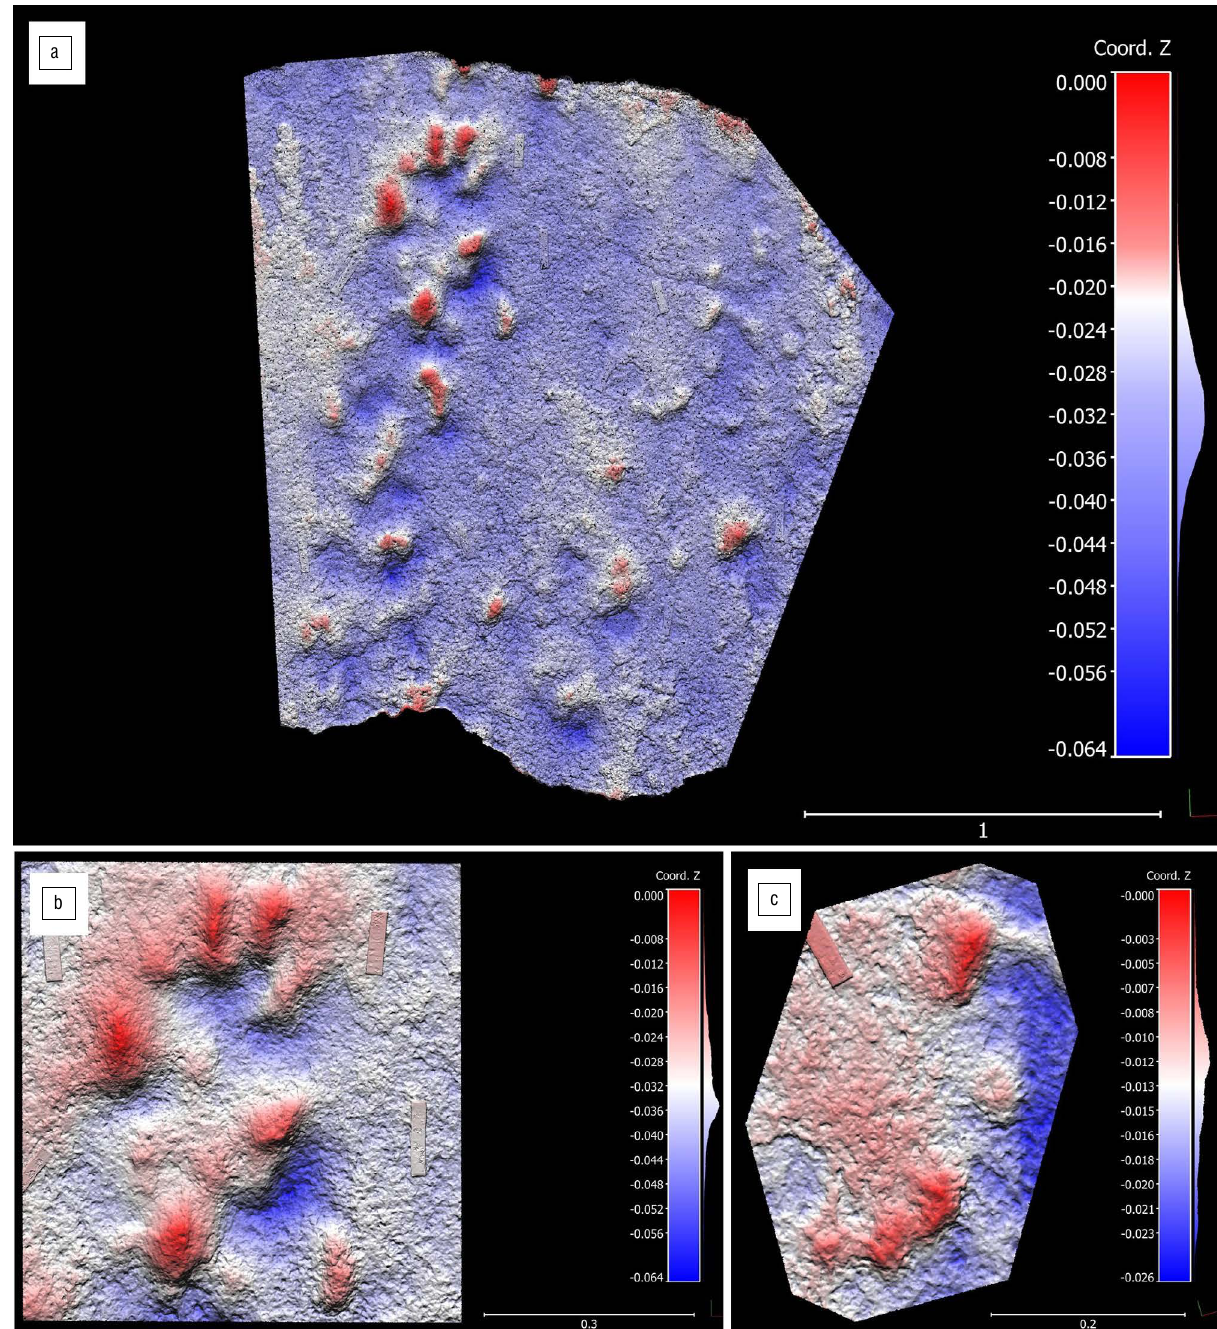
Figure 8: (a) Photogrammetry colour mesh of the Site 2 hyporelief surface, using 193 images. Photos were taken an average of 73.4 cm from the surface. The reprojection error is 0.427 pix. Vertical and horizontal scales are in metres. (b) Tight view of Tracks A9 – A15, with same photogrammetry metrics as (a). Vertical and horizontal scales are in metres. (c) Tight view of Track B5 and B6, showing probable left-right sequence, with same photogrammetry metrics as (a). Vertical and horizontal scales are in